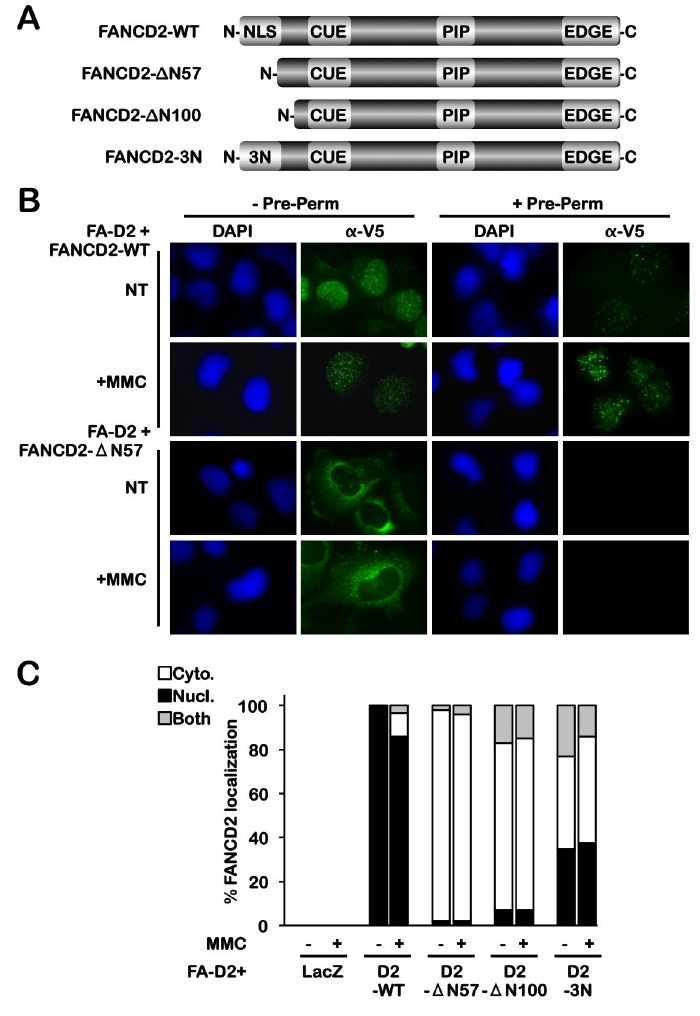
Figure 2. The FANCD2 NLS is required for the nuclear localization of FANCD2. ( A ) Schematic diagram of the FANCD2 constructs generated in this study. In addition to the NLS, FANCD2 harbors a CUE (for coupling of ubiquitin conjugation to endoplasmic reticulum degradation) ubiquitin-binding domain [47], a PCNA-interaction motif or PIP-box [19], and a carboxy-terminus EDGE motif [10]. ( B ) FA-D2 cells stably expressing FANCD2-WT and FANCD2-∆N57 were incubated in the absence (NT) or presence of 40 nM MMC for 24 h. Cells were then incubated in the absence (-Pre-Perm) or presence (+Pre-Perm) of pre- permeablization buffer, fixed, stained with mouse monoclonal anti-V5 antibody (green) and counterstained with DAPI (blue). ( C ) FA- D2 cells stably expressing LacZ, FANCD2-WT, FANCD2-∆N57, FANCD2-∆N100, and FANCD2-3N were incubated in the absence (NT) or presence of MMC for 24 h, fixed, and stained with rabbit polyclonal anti-FANCD2 antibody, and counterstained with phalloidin and DAPI. At least 300 cells were scored for cytoplasmic (Cyto.), nuclear (Nucl.), and both cytoplasmic and nuclear (Both) localization of